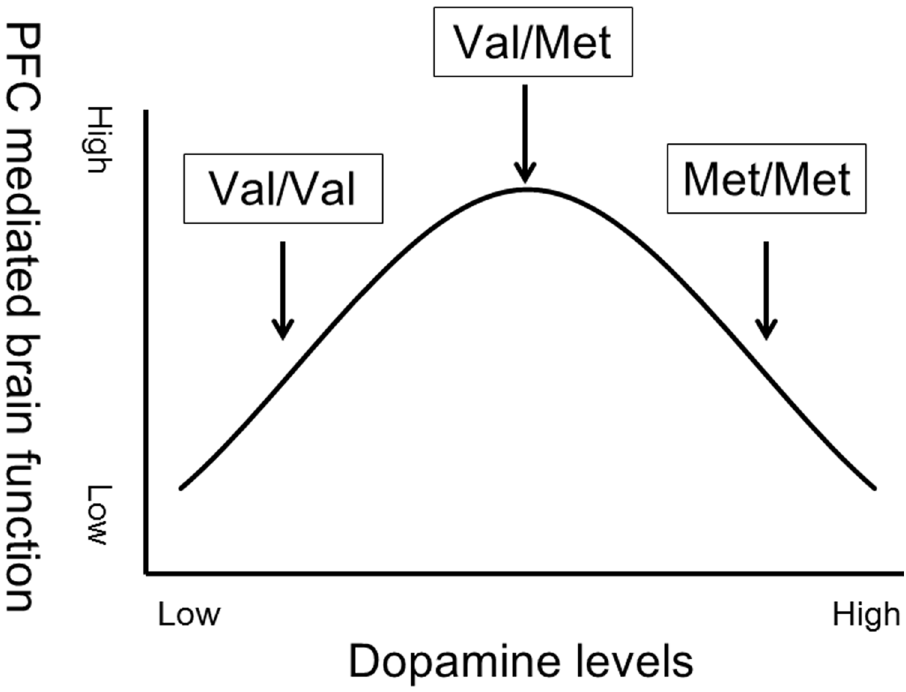
Fig 1. Hypothetical inverted U-shaped relationship between prefrontal cortex (PFC) brain function and dopamine levels. Intermediate COMT activity and dopamine levels present in Val/Met individuals are thought to be optimal for PFC-mediated brain